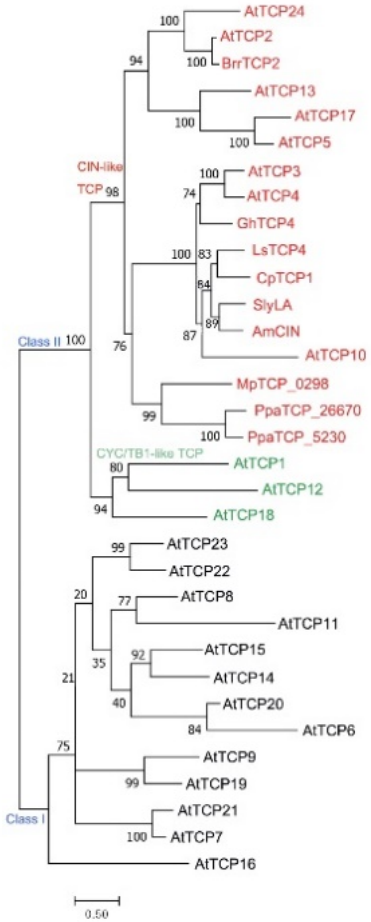
Figure 1. The phylogeny of TCP transcription factors, including all the TCP proteins in Arabidopsis thaliana and the CIN-like TCPs of other species mentioned in this review. Multiple alignments of the full-length TCP proteins were conducted using MAFFT Version 7[15] with L-INS-i iterative refinement methods. The phylogenetic tree was constructed with the Maximum Likelihood (ML)